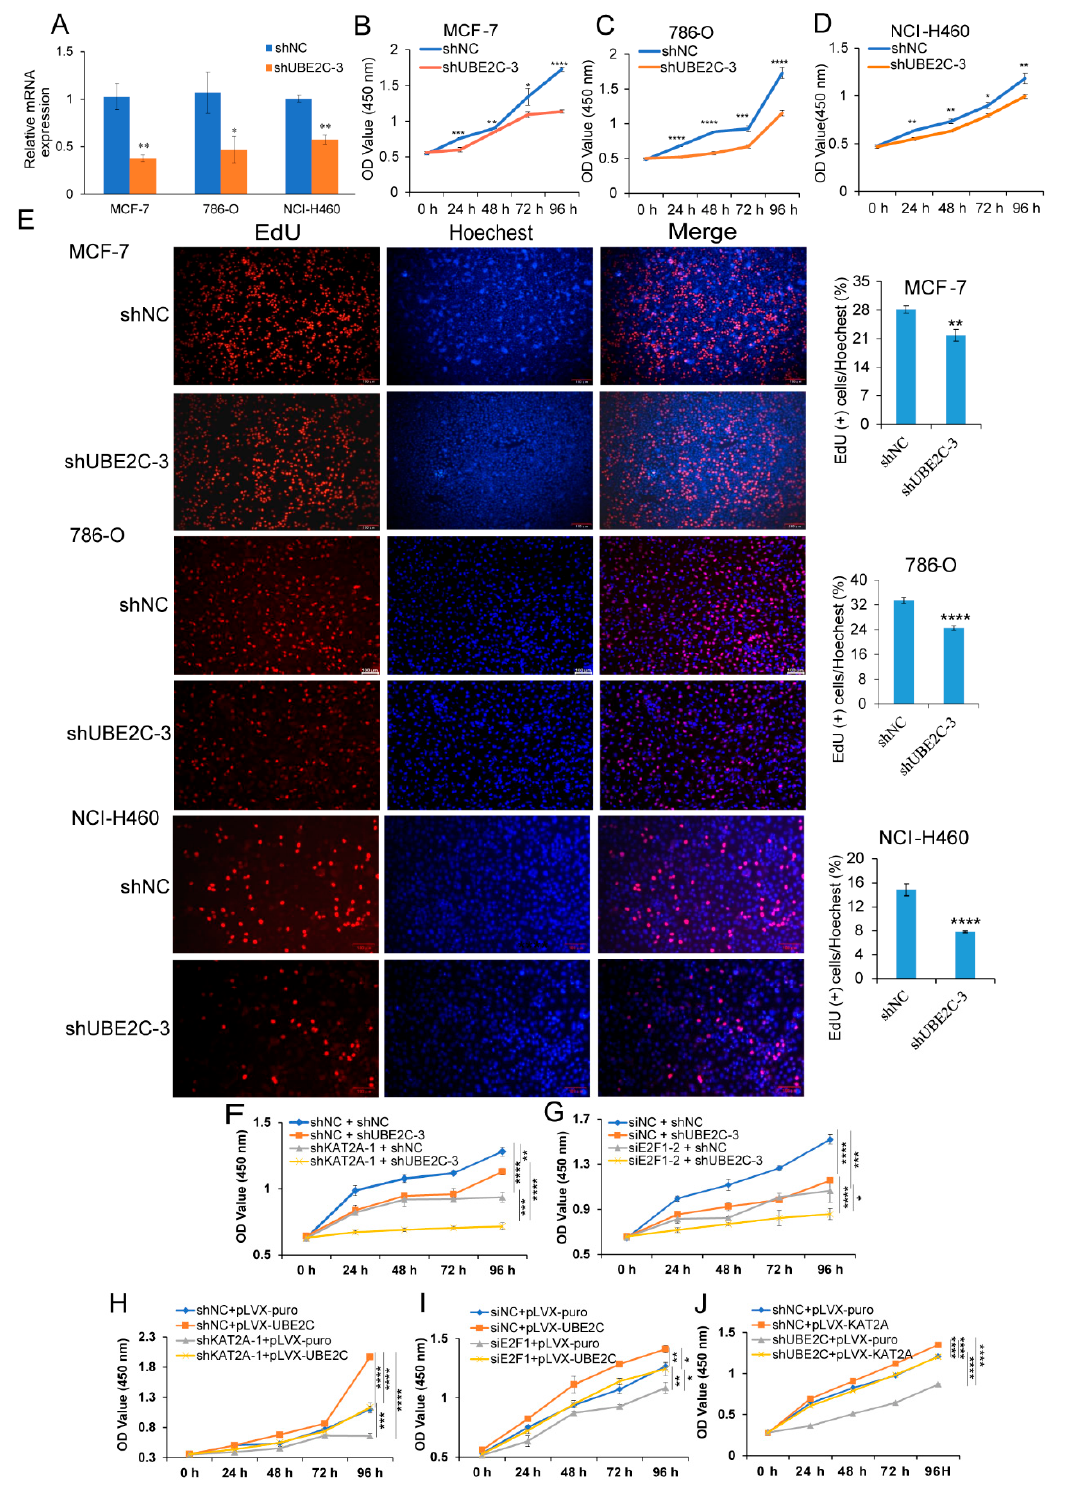
Figure 6. Interference with UBE2C significantly inhibits cancer cell proliferation. ( A ) The expression level of UBE2C was detected by qRT-PCR after interference with UBE2C and NC in MCF-7, 786-O, and NCI-H460 cells. Data are representative from four independent experiments. CCK-8 results of MCF-7 ( B ), 786-O ( C ), and NCI-H460 ( D ) cells interfered with UBE2C and NC at different time points. Data are representative from at least six independent experiments. ( E ) EdU results of MCF-7, 786-O, and NCI-H460 cells interfered with UBE2C and NC at 48 h. EdU marks the proliferating cells, Hoechest represents the nucleus, and Merge represents an overlay of EdU and Hoechest. 10 × magnification. Data are representative from three independent experiments.